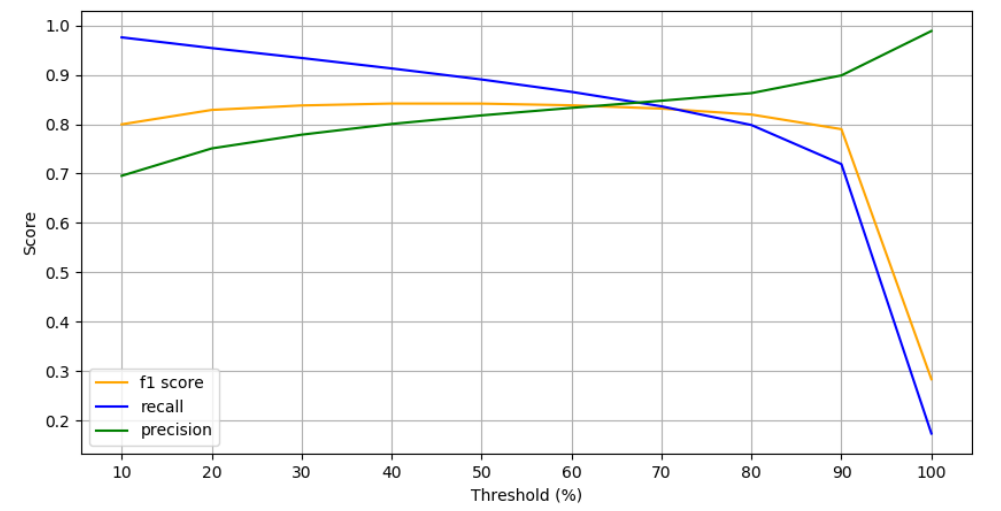
Figure 15. The accuracy variation of energy-based filtering with fuzzy clustering as the threshold is varied.